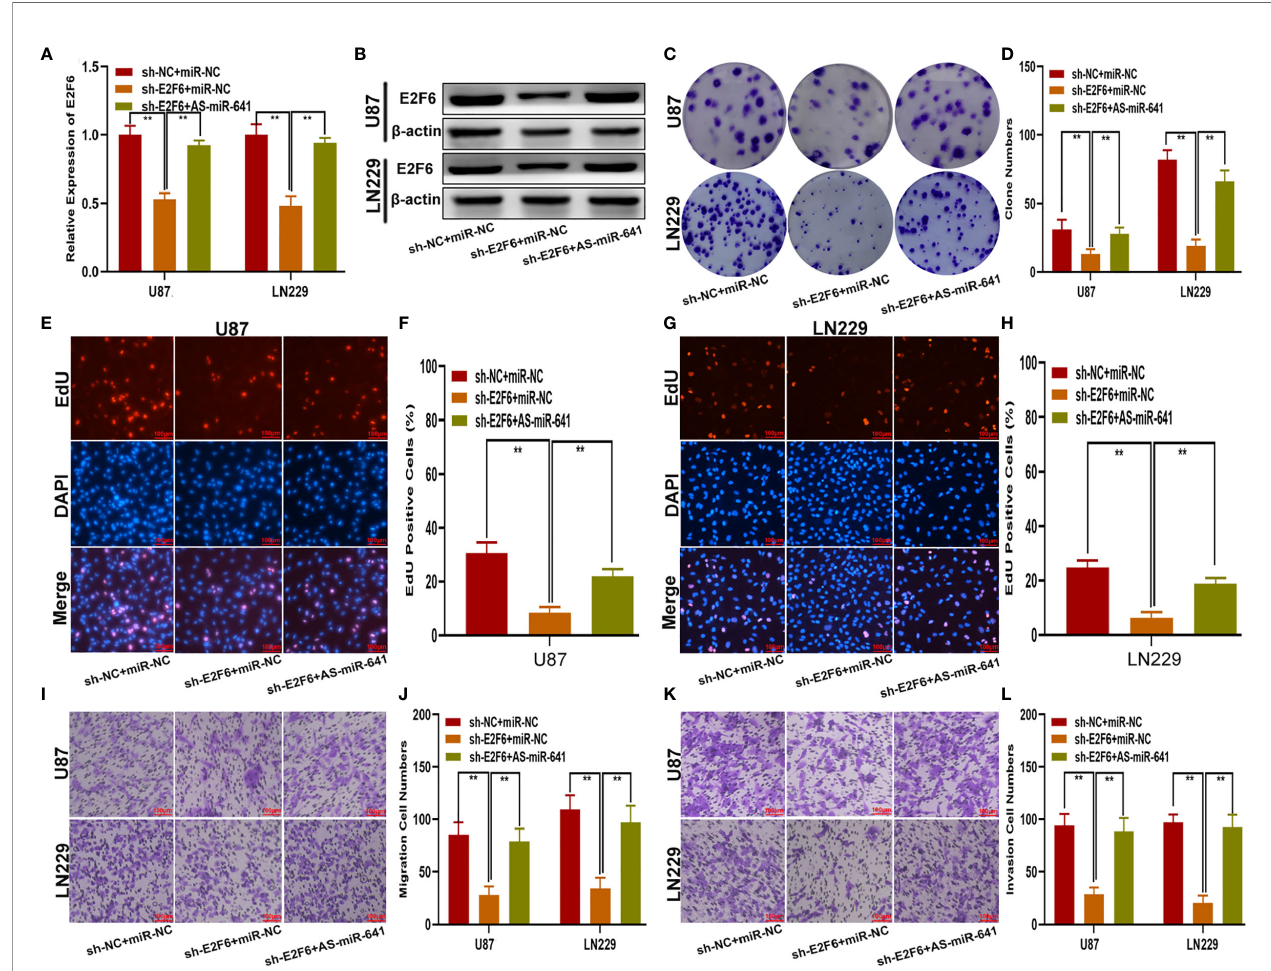
FIGURE 7 | E2F6 promotes glioma proliferation, migration and invasion in vitro. (A, B) The relative expression of E2F6 in U87 and LN229 cells transfected with sh- E2F6 or sh-E2F6 together with miR-641 inhibitor, as measured by qRT-PCR and western blot. (C, D) The proliferation of U87 and LN229 cells transfected with sh- E2F6 or sh-E2F6 together with miR-641 inhibitor, as measured by clone formation assays. (E – H) The proliferation of U87 and LN229 cells transfected with sh-E2F6 or sh-E2F6 together with miR-641 inhibitor, as measured by EdU assays. (I, J) The migration of U87 and LN229 cells transfected with sh-E2F6 or sh-E2F6 together with miR-641 inhibitor, as measured by Transwell assays. (K, L) The invasion of U87 and LN229 cells transfected with sh-E2F6 or sh-E2F6 together with miR-641 inhibitor, as measured by Transwell assays. **P <